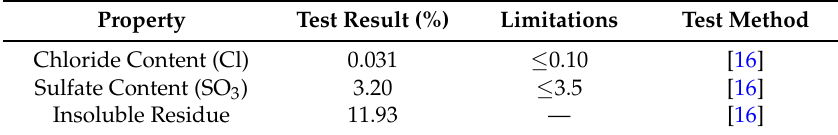
Table 2. The chemical properties of the Pozzolanic Portland Cement, Type